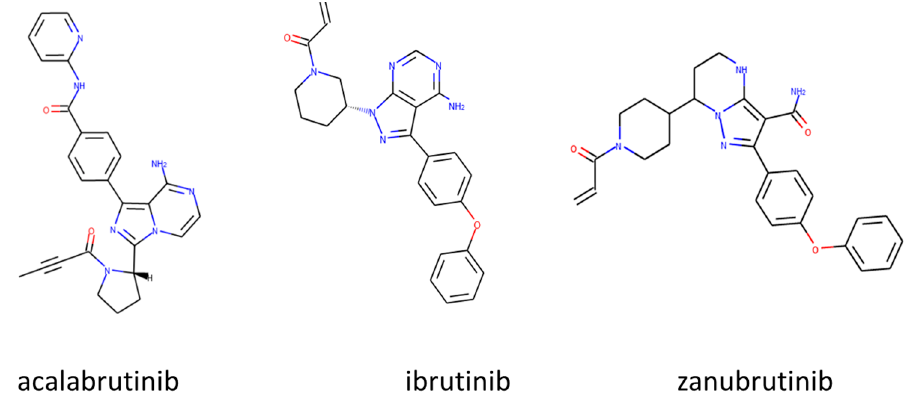
Figure 4. BTKIs approved by the FDA [67–69].